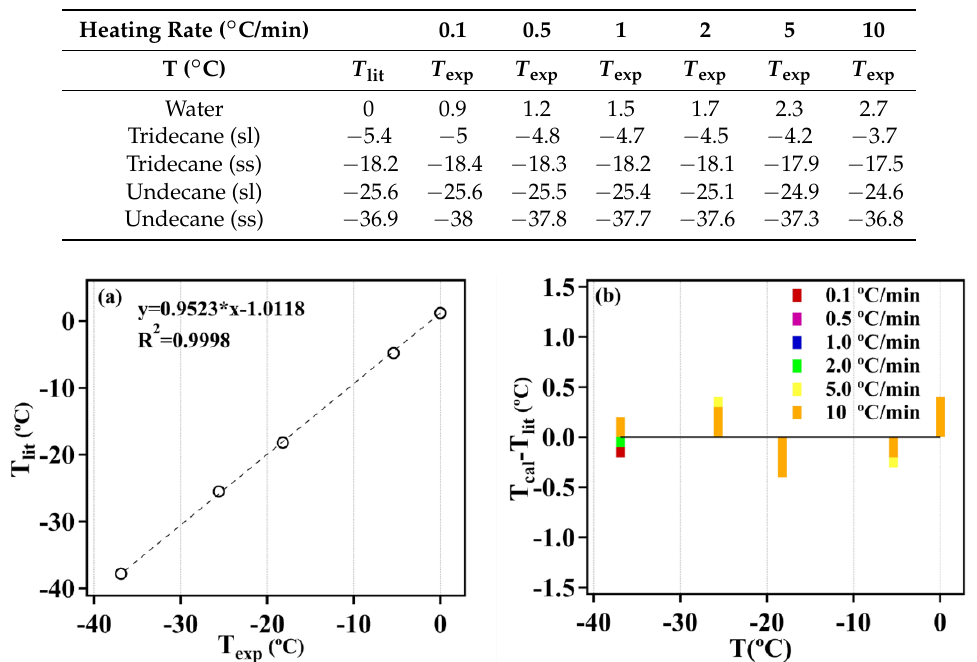
Table 1. Literature ( T lit ) phase transition point and experimentally determined phase transition temperatures ( T exp ) at different heating rates as shown in Figure 4a.